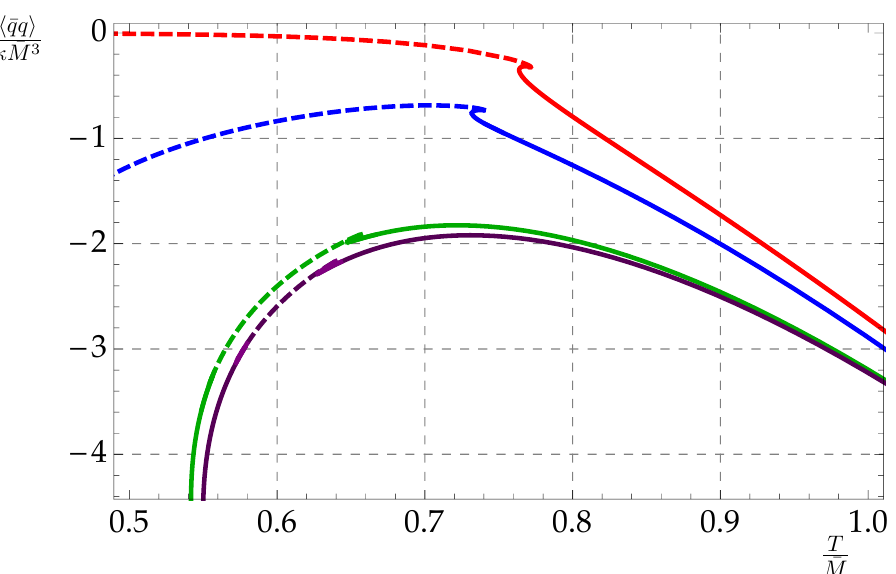
Figure 3 . Quark condensate h (cid:22) qq i =(cid:20) (cid:22) M 3 as a function of T= (cid:22) M . Red, blue, green, and purple curves (top to bottom) correspond to b= (cid:22) M 2 = f 0 ; 2 ; 3 : 3 ; 3 : 4 g respectively. The dashed segments correspond to Minkowski embeddings, while the continuous segments correspond to the black hole embeddings. U is a function of the magnetic (cid:12)eld and the temperature, said term will a(cid:11)ect the value 1 of the quark condensate in a non-trivial